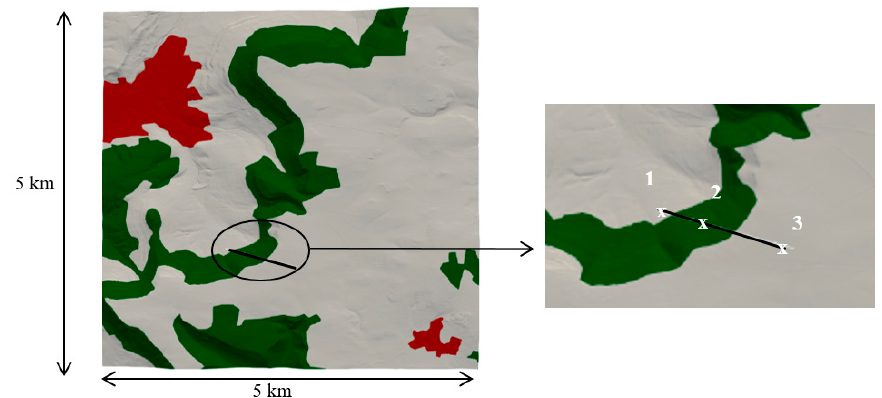
Figure 13. Position of the horizontal (black line) and vertical (1, 2 and 3) lines for the evaluation related to Figures 14 and 15.